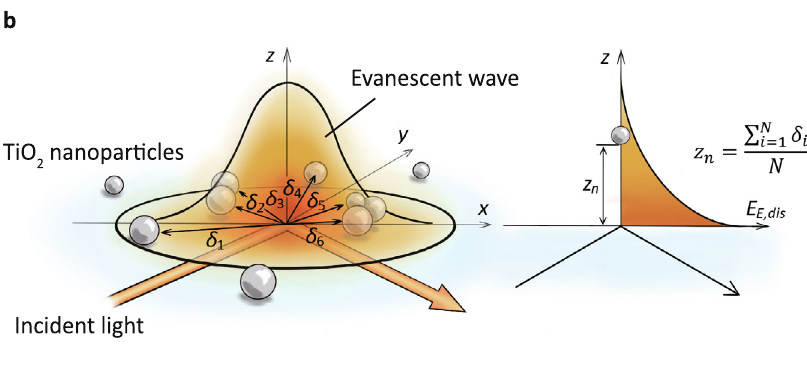
Fig. 3 Radiant energy dissipated in TiO 2 -QOFs. a Radiant energy dissipated in the three TiO 2 -QOFs when TiO 2 -QOFs were exposed to air and water; b schematic of the normalization of the distances between the optical fi ber surface and the coated TiO 2 nanoparticles in an evanescent fi eld (conditions: light intensity = 7.02 mW/cm 2 , wavelength = 365 nm, TiO 2 coating length = 6.5 cm, irradiation duration = 4